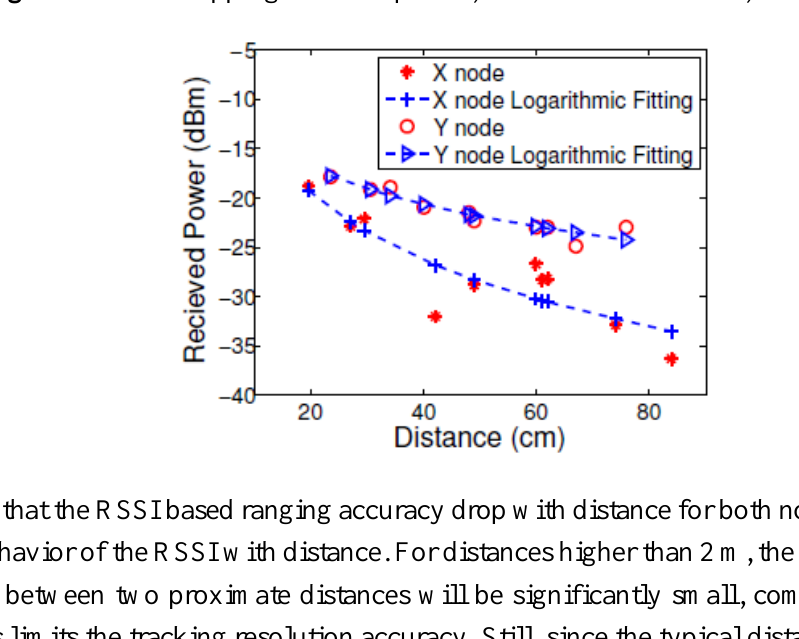
Figure 5. RSSI mapping between power, and distance for the x, and y